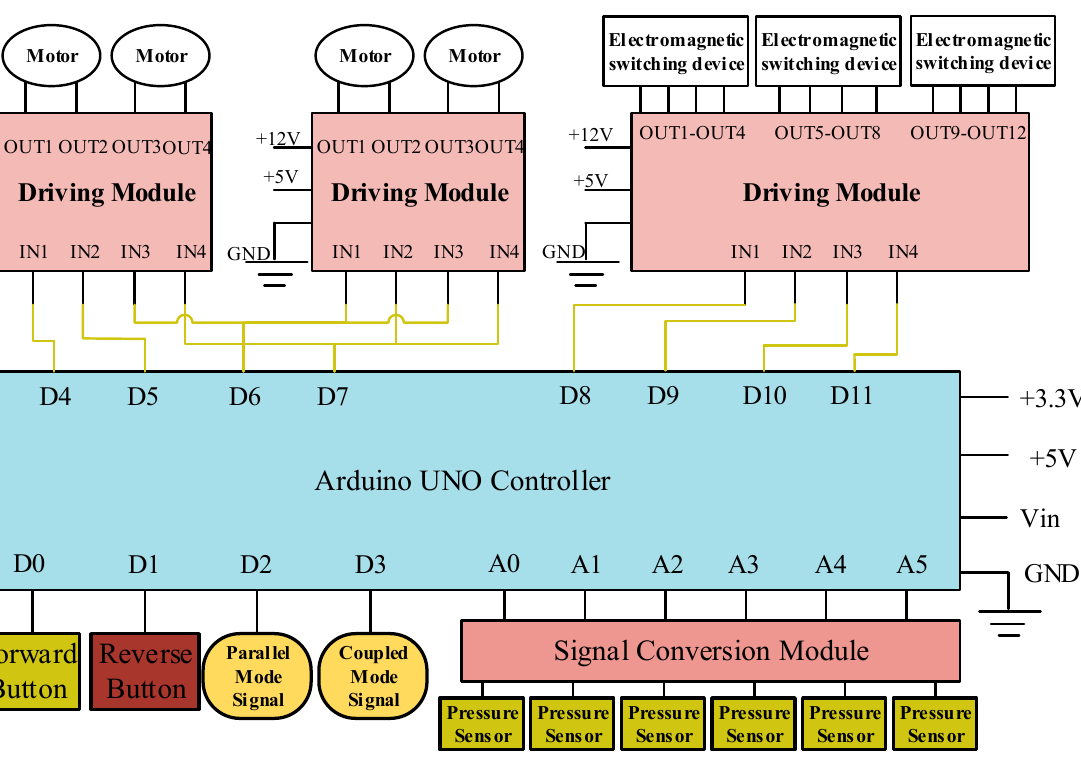
22 of 30 Figure 17. Stability analysis for the COSA mode.